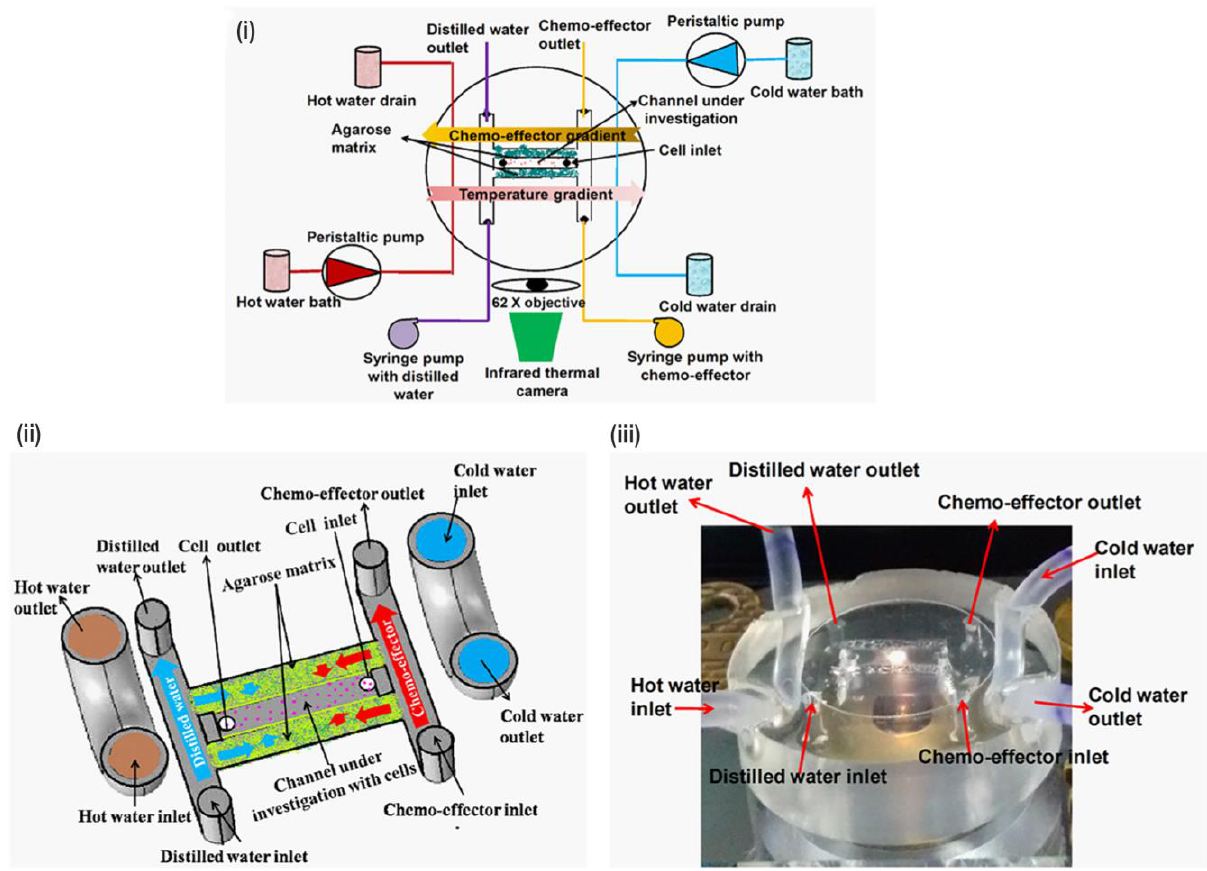
FIGURE 7: Temperature and the chemical gradients were generated in a single microfluidic device to study the combined effect of thermo- taxis and chemotaxis in bacteria. (i) Schematic diagram of the device integrated with an infrared thermal camera-mounted microscope. (ii) Schematic diagram illustrating how the device generates chemical and thermal gradient across channel under investigation with cells. (iii) The microfluidic device used in the experiment. Reproduced from